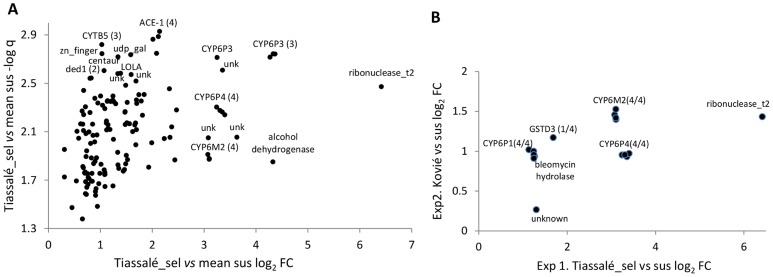
Genes significantly overexpressed (relative to susceptible samples) in (A) Tiassalé bendiocarb resistant samples in Exp1, and (B). both Tiassalé and Kovié samples.Plots show: (A). Log2-transformed fold-changes (FC) plotted against -log10 transformed q-values (multiple-testing-corrected probabilities) for bendiocarb-selected Tiassalé samples versus the average of the three susceptible populations; (B) Comparison of Kovié FC against Tiassalé-selected FC for probes significant in both experiments. For genes represented by multiple probes, numbers in parentheses indicate the number of probes significant/total.